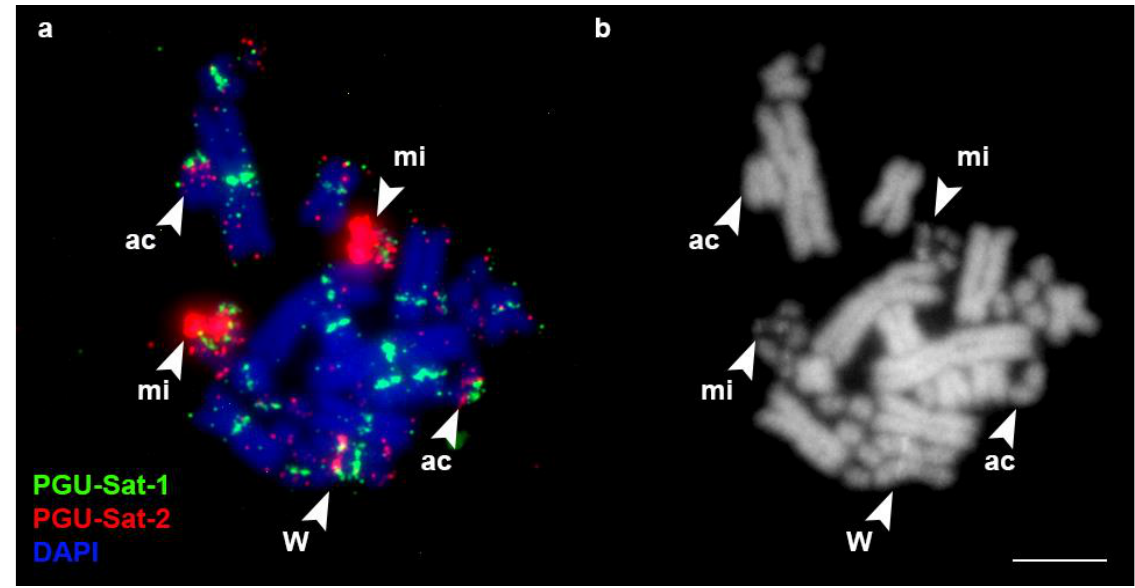
Figure 1. Localization of the satellites PGU-Sat-1 and PGU-Sat-2 in the chromosomes of P. guttatus. mi: the PGU-Sat-2 bearing microchromosome; ac: the acrocentric macrochromosome with both PGU-Sat-1 and PGU-Sat-2 signals; W: the W chromosome. (a) Merged image; (b) DAPI channel. Scale bar: 10 μm.